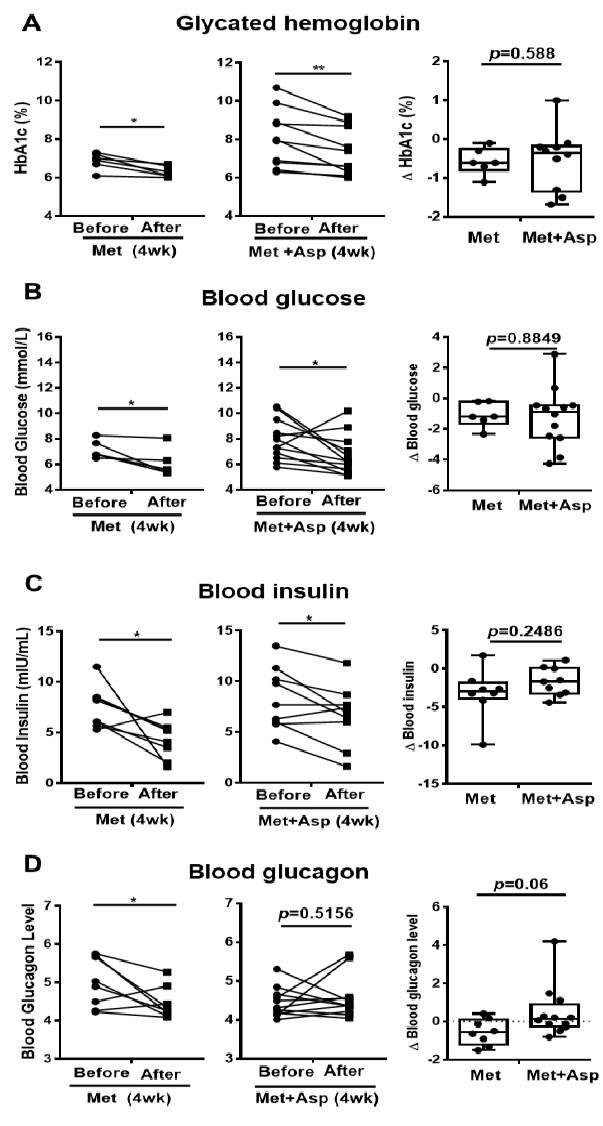
Figure 7. Blood profiles of clinical trial patients with metformin or metformin + aspirin for 4 weeks. ( A – D ) The HbA1c ( A ), glucose ( B ), insulin ( C ), and glucagon ( D ) profiles in type 2 diabetic patients’ blood before and after 4 week-treatment of metformin or metformin + aspirin, n = 6–12 patients/group. * p < 0.05, ** p < 0.01.